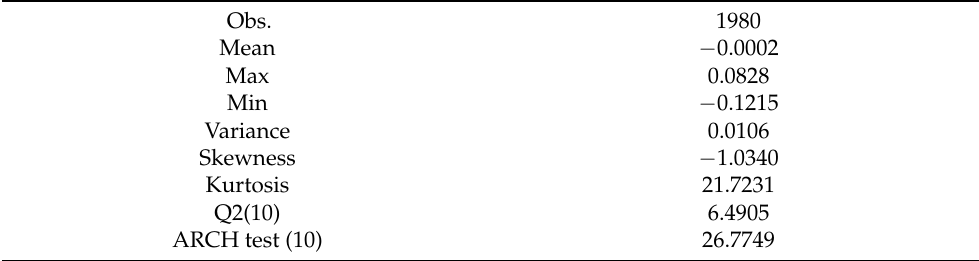
Table 3. Data characteristics.